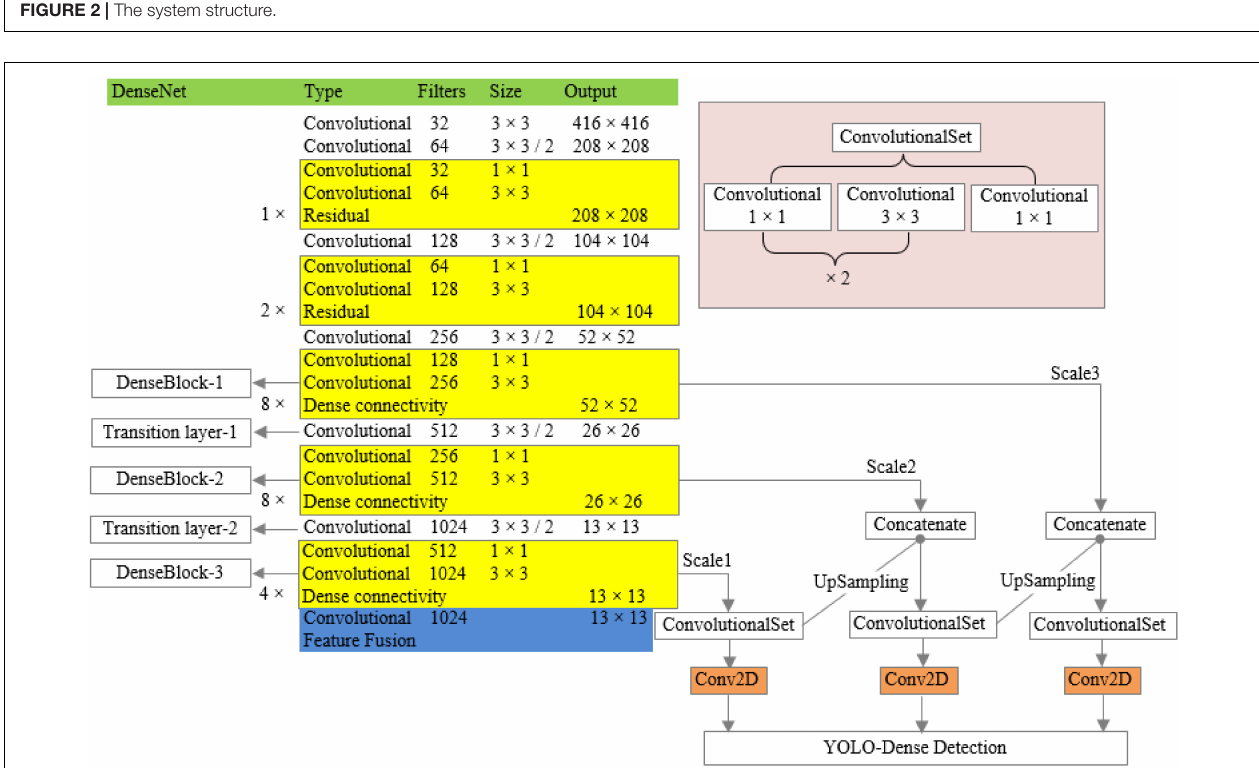
FIGURE 2 | The system structure.